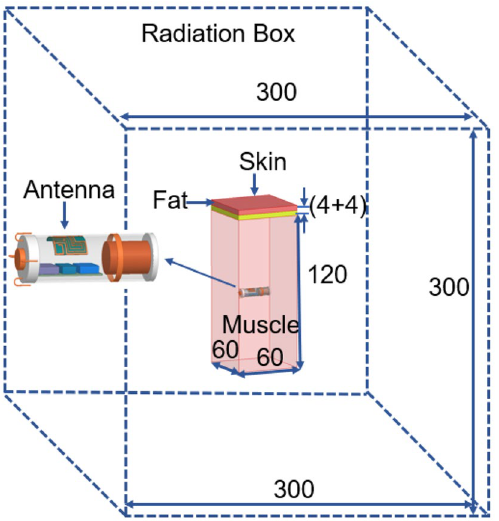
Figure 3. Simulation set-up for the proposed antenna in a multi-layer phantom model for the leadless transcatheter pacing system.